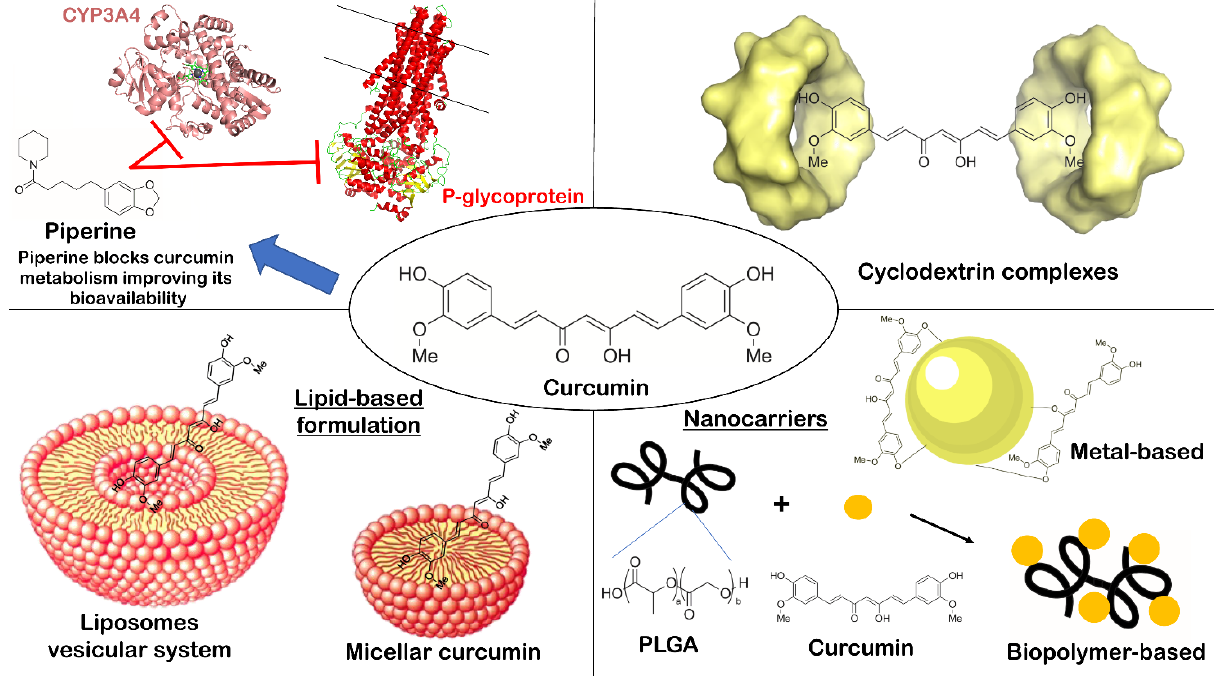
Figure 1. Schematic representation of the main strategies for improving the bioavailability of curcumin. CYP3A4 and P-glycoprotein were downloaded from protein data bank (PDB https://www.rcsb.org/; PDB IDs 7KVS [51] and 6C0V [52], respectively). Cyclodextrin structure was downloaded from The Cambridge Crystallographic Data Centre (CCDC https://www.ccdc.cam.ac.uk/; ID 762697; WEWTOJ) [53]. Structures were manipulated by PyMOL software (The PyMOL Molecular Graphics System, v1.8; Schrödinger, LLC, New York, 2015). Au–curcumin nanoparticle was designed according to Priyadarsini [46] .